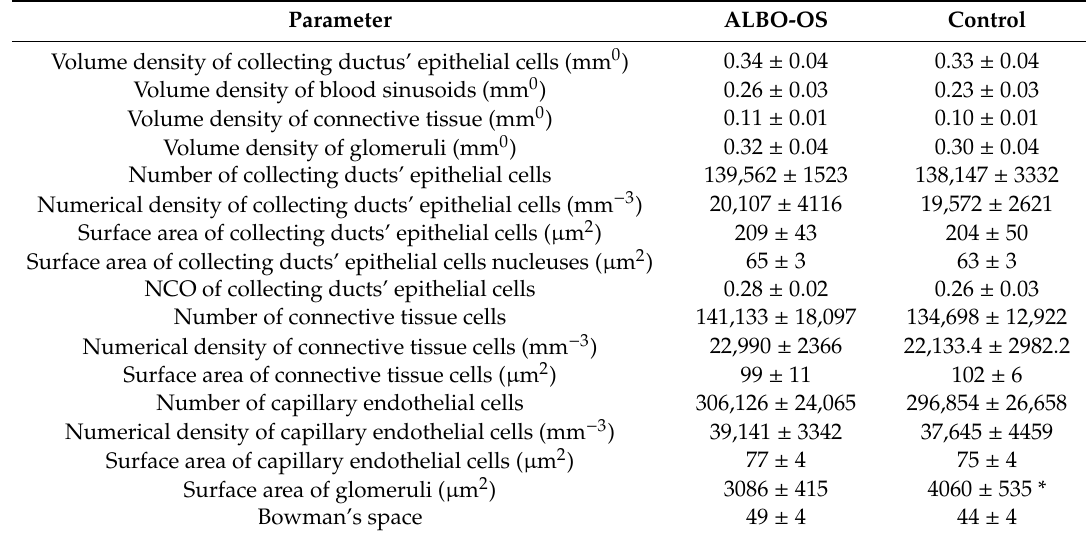
Table 4. Stereological parameters of kidneys of the control group and treated group of rats; values are shown as mean ± SD (* p < 0.05; t -test).